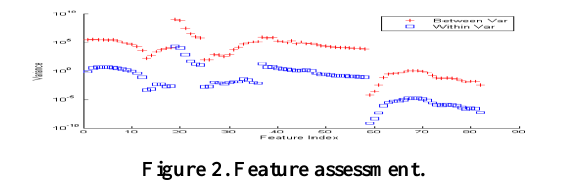
Figure 4. Wearable